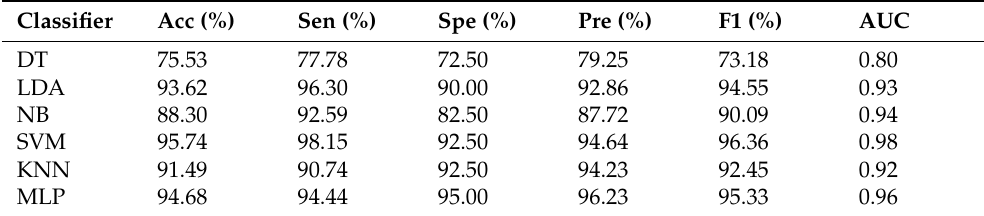
Table 4. Performance measures achieved by the classifiers trained and tested with Deep/LBP features. Classifier